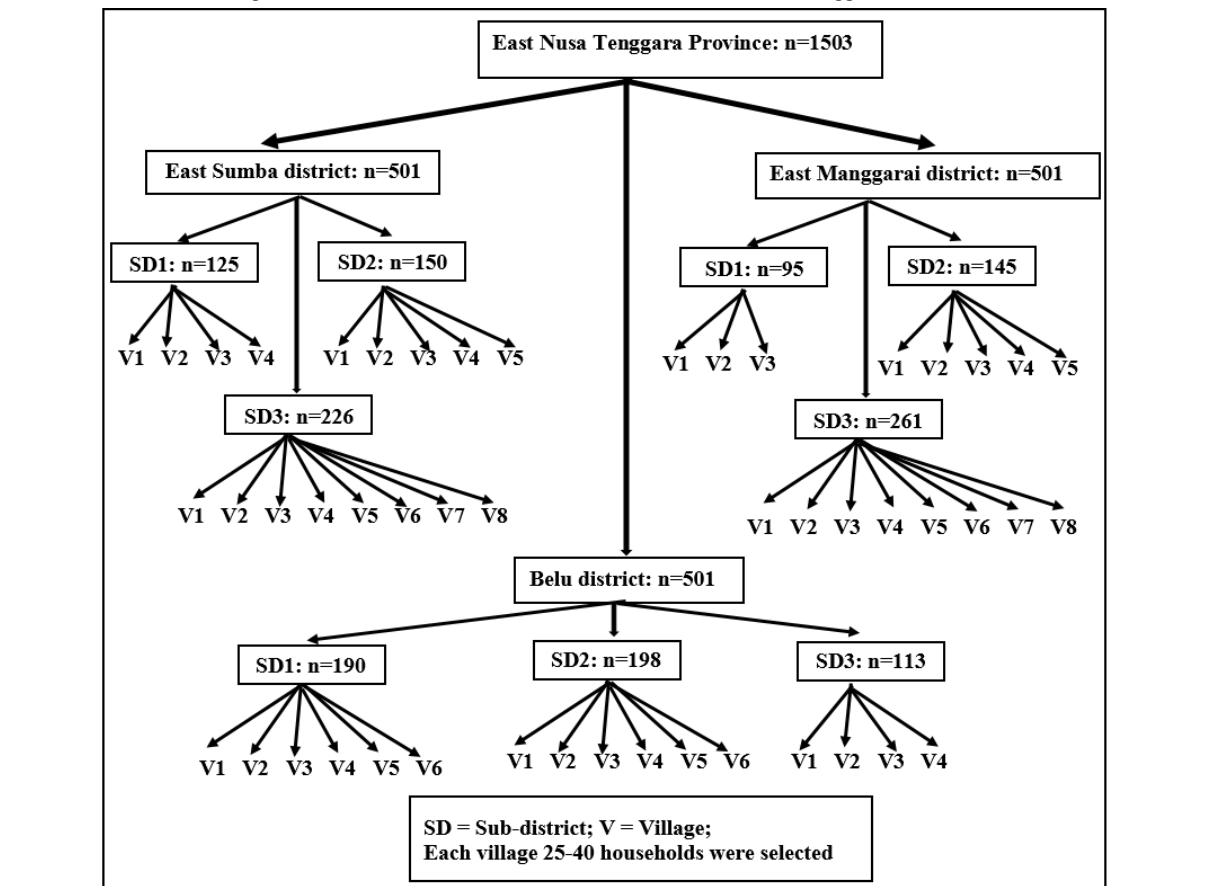
Figure 2. Flow chart for selecting clusters and households in ENTP Indonesia. ENTP: East Nusa Tenggara